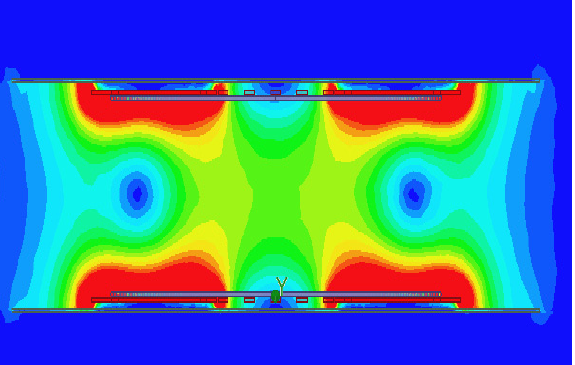
Figure 4. The magnetic induction intensity of the non-meshed aluminium plate electromagnetic shielding.